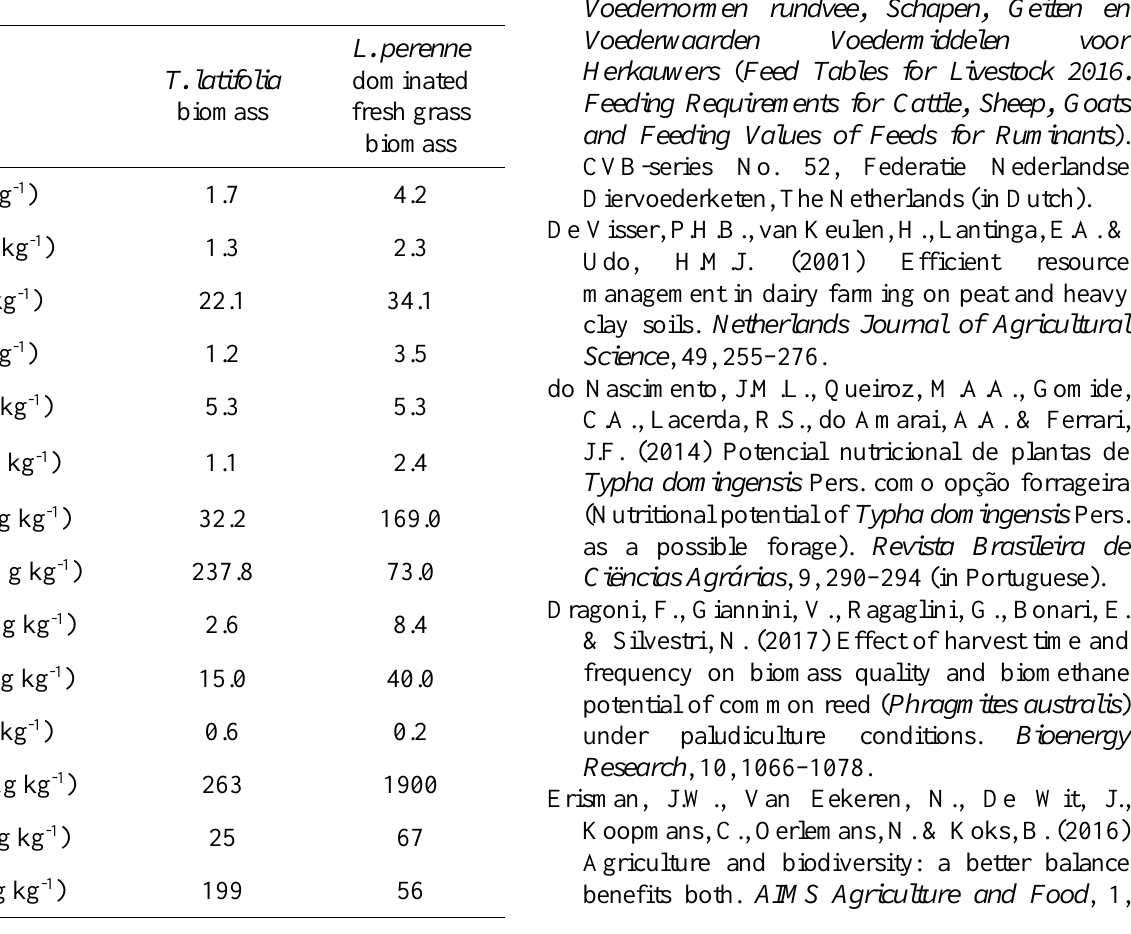
Table 8. Average dry matter mineral contents in T. latifolia biomass Experiment II) and fresh grass from L. perenne dominated dairy grasslands in The Netherlands (Eurofins Agro